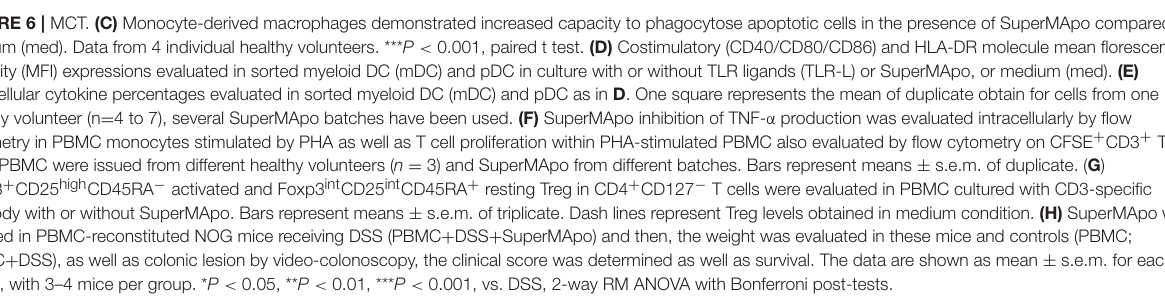
FIGURE 6 | MCT. (C) Monocyte-derived macrophages demonstrated increased capacity to phagocytose apoptotic cells in the presence of SuperMApo compared to medium (med). Data from 4 individual healthy volunteers. *** P < 0.001, paired t test. (D) Costimulatory (CD40/CD80/CD86) and HLA-DR molecule mean florescence intensity (MFI) expressions evaluated in sorted myeloid DC (mDC) and pDC in culture with or without TLR ligands (TLR-L) or SuperMApo, or medium (med). (E) Intracellular cytokine percentages evaluated in sorted myeloid DC (mDC) and pDC as in D . One square represents the mean of duplicate obtain for cells from one healthy volunteer (n = 4 to 7), several SuperMApo batches have been used. (F) SuperMApo inhibition of TNF- α production was evaluated intracellularly by flow cytometry in PBMC monocytes stimulated by PHA as well as T cell proliferation within PHA-stimulated PBMC also evaluated by flow cytometry on CFSE + CD3 + T cells. PBMC were issued from different healthy volunteers ( n = 3) and SuperMApo from different batches. Bars represent means ± s.e.m. of duplicate. ( G ) Foxp3 + CD25 high CD45RA − activated and Foxp3 int CD25 int CD45RA + resting Treg in CD4 + CD127 − T cells were evaluated in PBMC cultured with